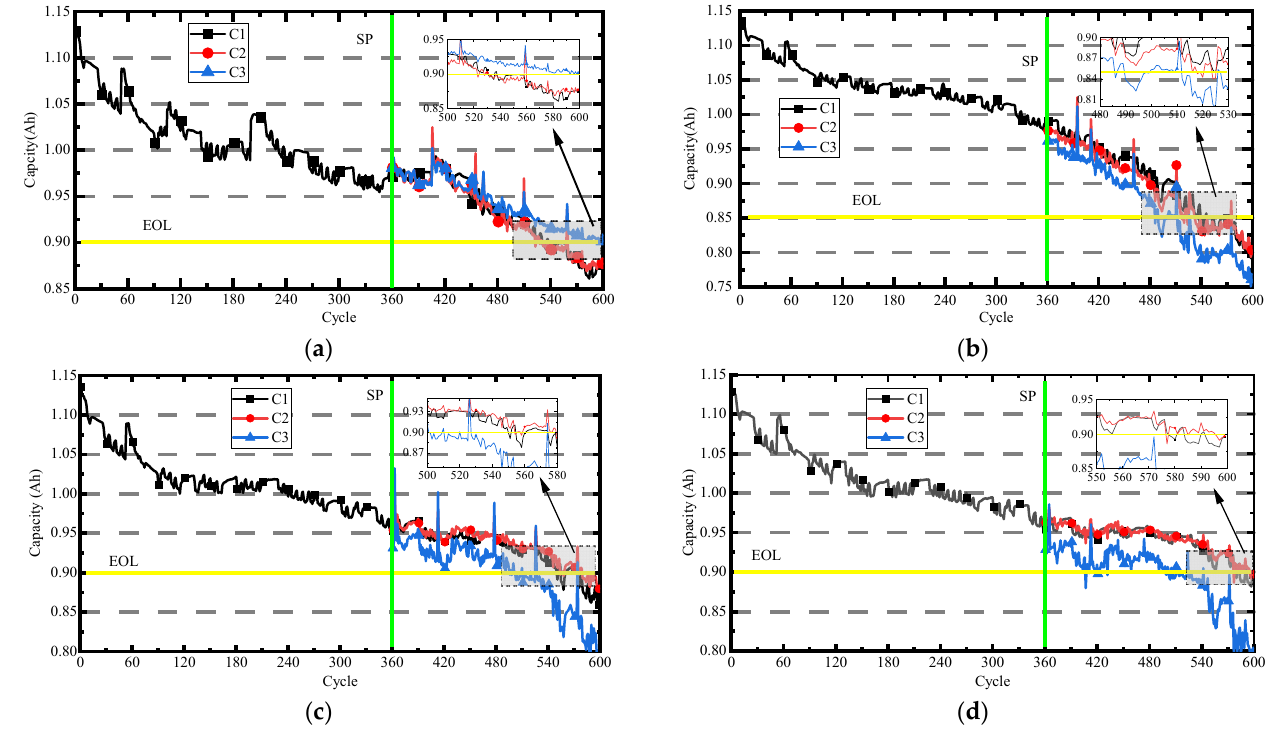
Figure 8. Short–term prediction experimental results curve. ( a ) CS2–35, SP = 360; ( b ) CS2–36, SP = 360; 360; ( c ) CS2–37, SP = 360; ( d ) CS2–38, SP = 360. ( c ) CS2–37, SP = 360; ( d ) CS2–38, SP =